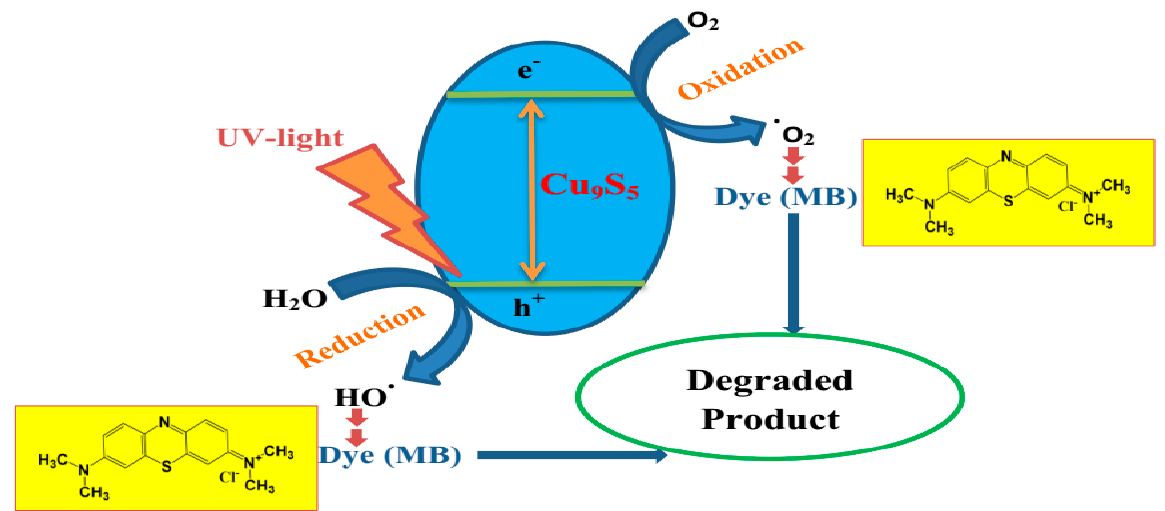
Figure 13. Degradation efficiency curves of MB at different irradiation times using ( a ) complex 1 and ( b ) complex 2 as precursors at 230 °C.